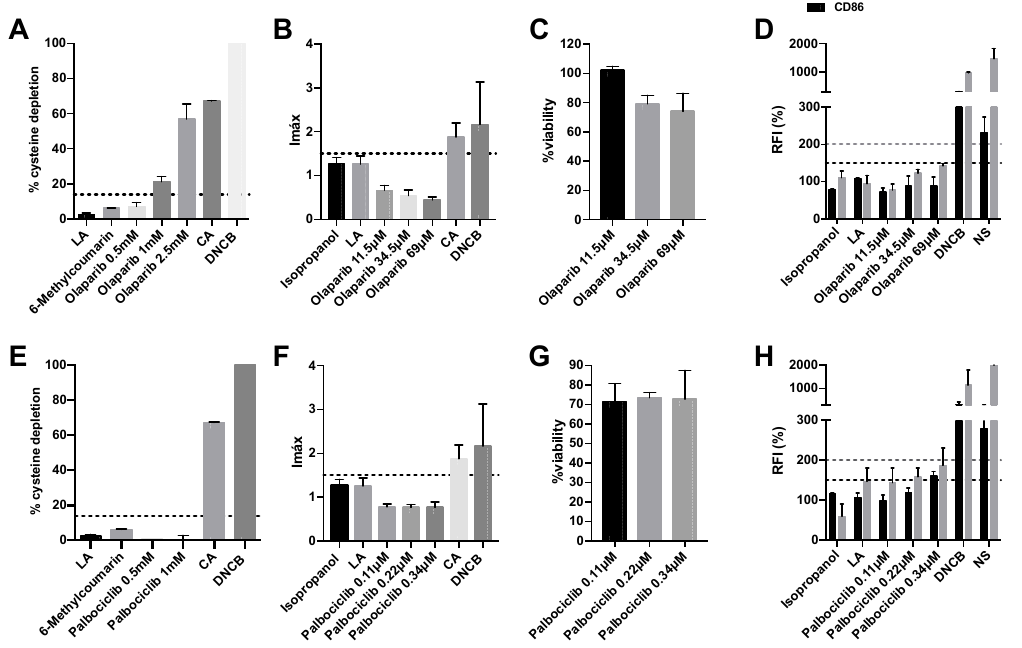
Figure 3. Analysis of delayed-type hypersensitivity of olaparib and palbociclib by direct peptide re- activity assay (DPRA), KeratinoSens TM assay, and human cell line activation test (hCLAT). ( A )